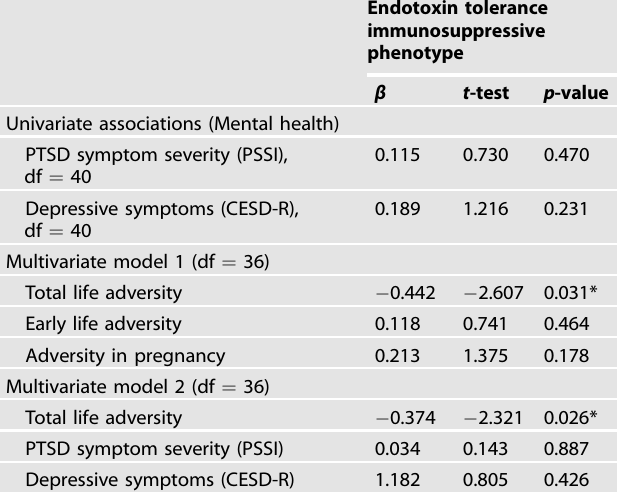
Table 4. Univariate and multivariate associations of total life adversity, adversity during sensitive periods, and mental health with the endotoxin tolerance